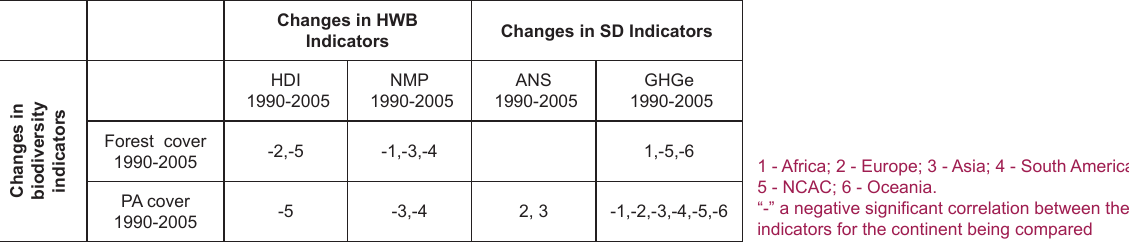
Table 3. Correlation between changes in biodiversity and HWB and SD indicators across the continents from 1990-2005. Only significant correlations (p < 0.05) are